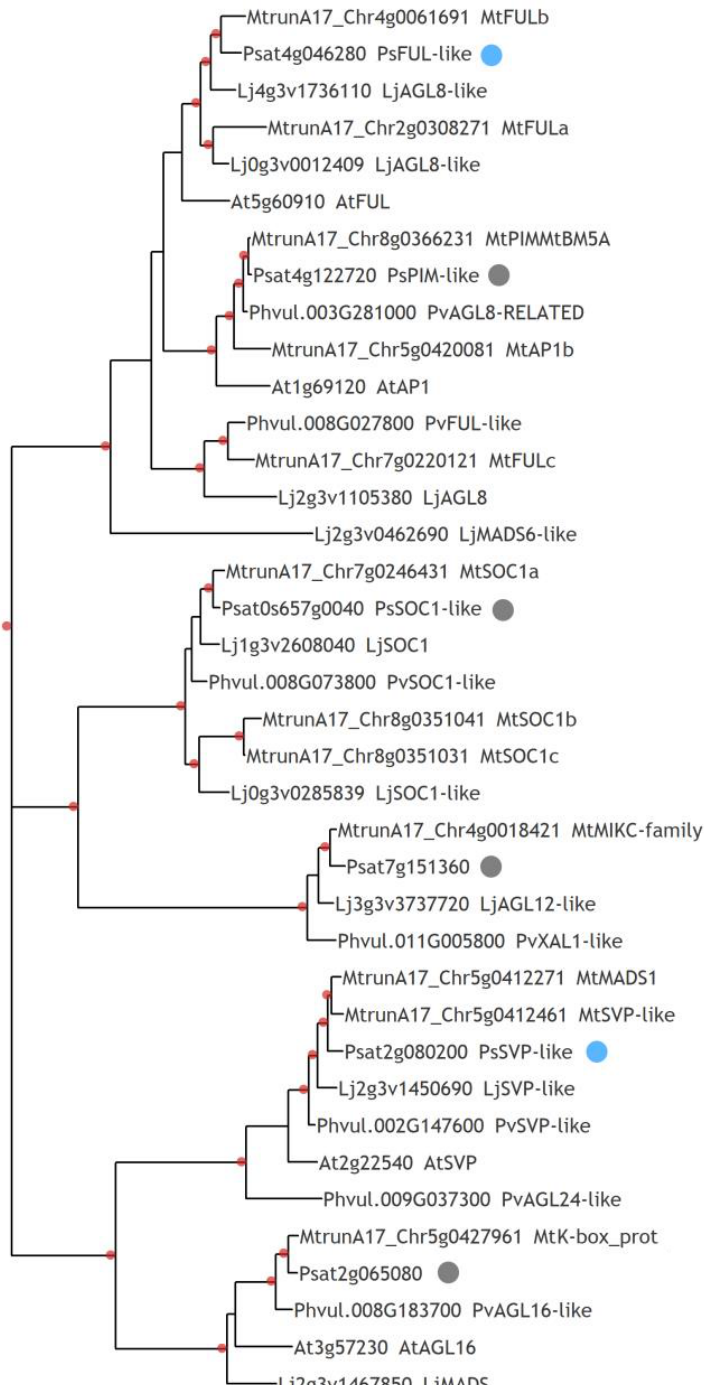
Figure 6. Phylogenetic tree constructed by the maximum likelihood method based on the amino acid sequences of the AGL family genes in P. sativum , P. vulgaris L. japonicus, A. thaliana, and M. truncatula . Red dots indicate over 0.7 support based on 1000 iterations of the bootstrap method. Blue dots indicate genes showing increased expression upon cytokinin treatment of sym33-3 mutant plants. Gray dots indicate genes whose expression in sym33-3 mutant nodules is lower than in wild-type pea nodules.